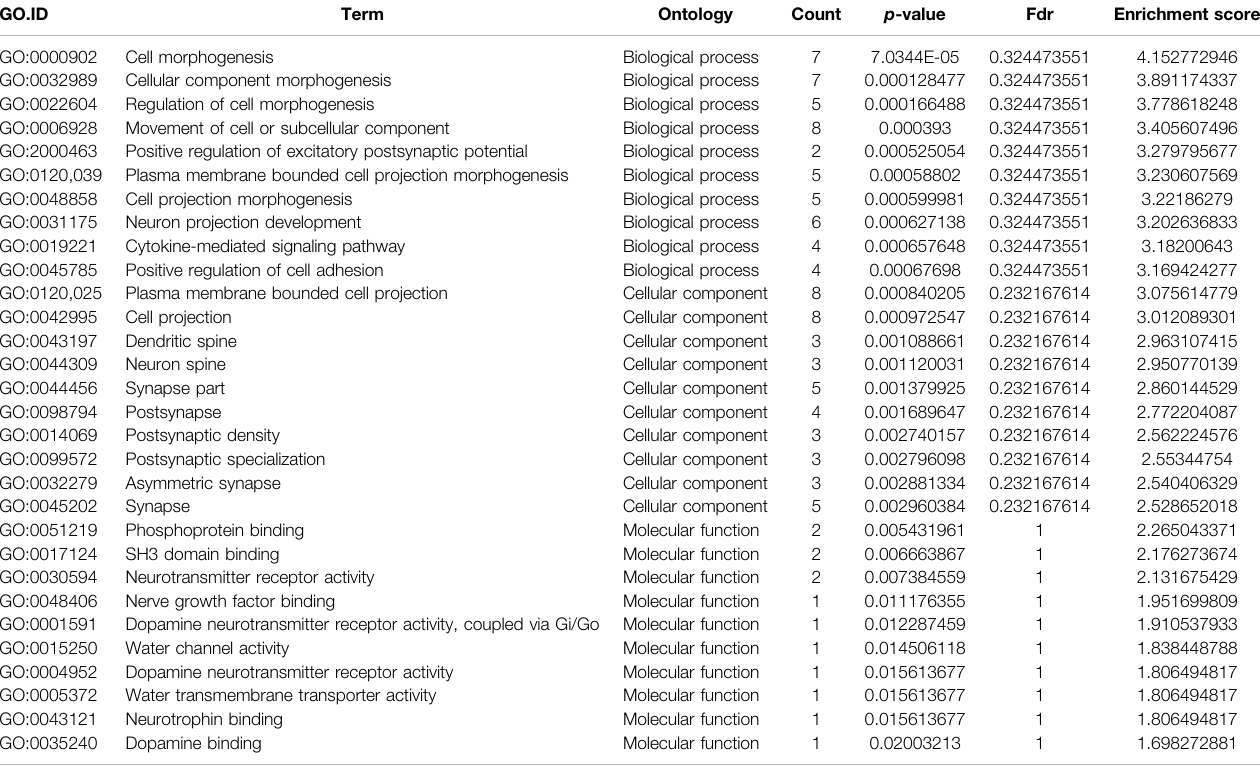
TABLE 3 | Gene Ontology analysis of the top ten hyper-methylated mRNAs.